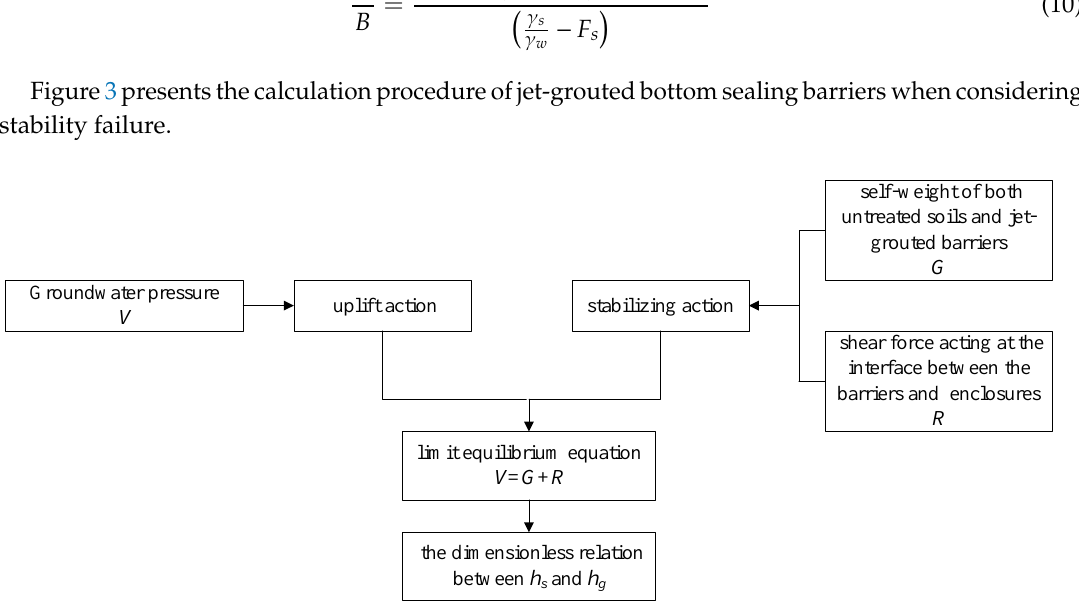
Figure 3. Calculation procedure of jet-grouted bottom sealing barriers considering instability failure.